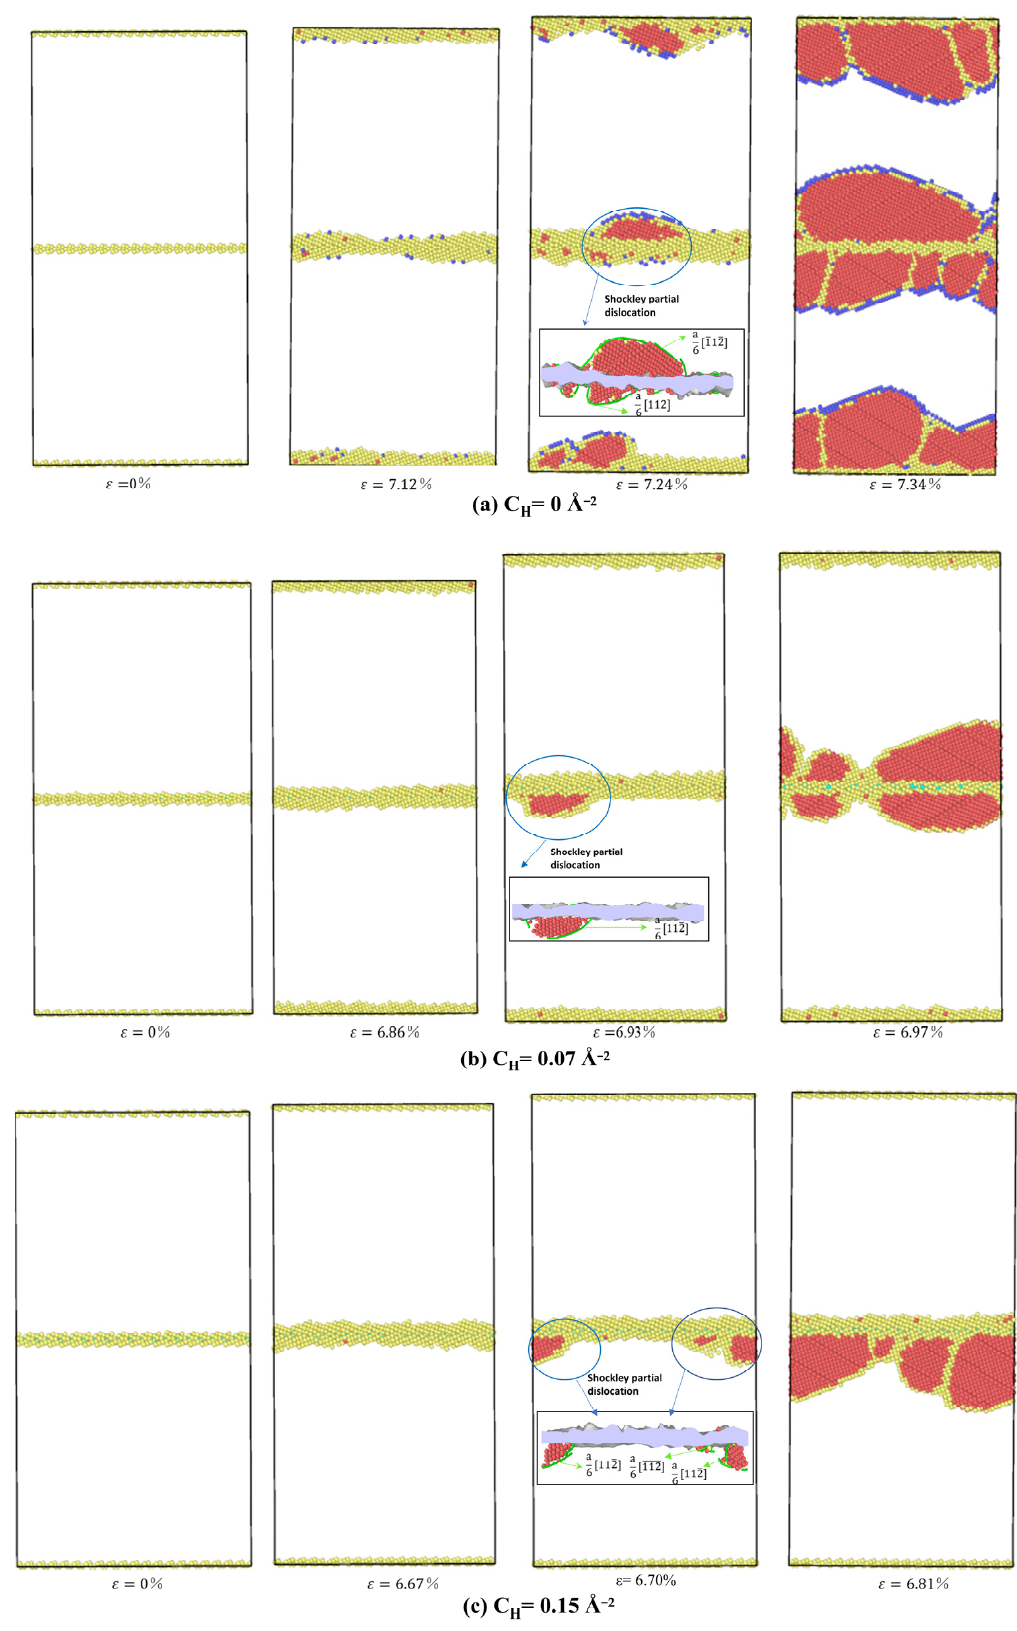
Figure 9. MD snapshots of dislocation nucleation from Ni bicrystal with Σ 5 (3 1 0) STGB for various H concentrations. Only the defective arrangement of atoms is shown.